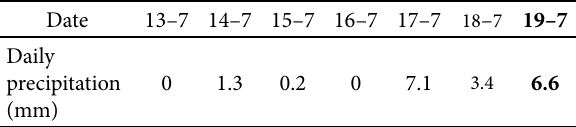
Table 1. Daily precipitation in the period 13 – 19/07/12. The daily precipitation amount recorded when the urban storm water runoff samples were taken is highlighted in bold